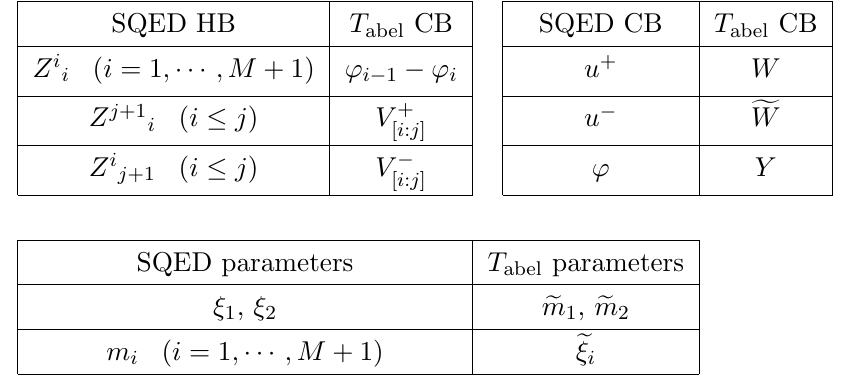
Table 4 . Mirror map of HB operators and CB operators between the SQED and T abel theories, and mirror map of FI and mass parameters, with ’ 0 (cid:17)